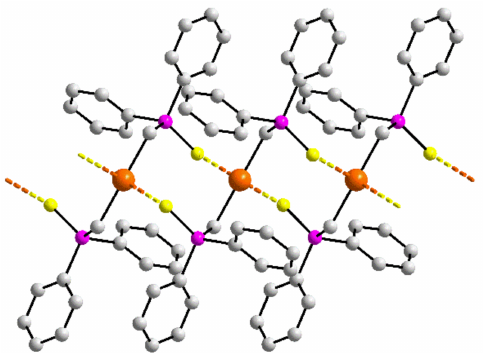
Figure 19. Supramolecular association in the crystal of 52 : one-dimensional chain with a helical topology and featuring two Hg ··· S interactions per mercury